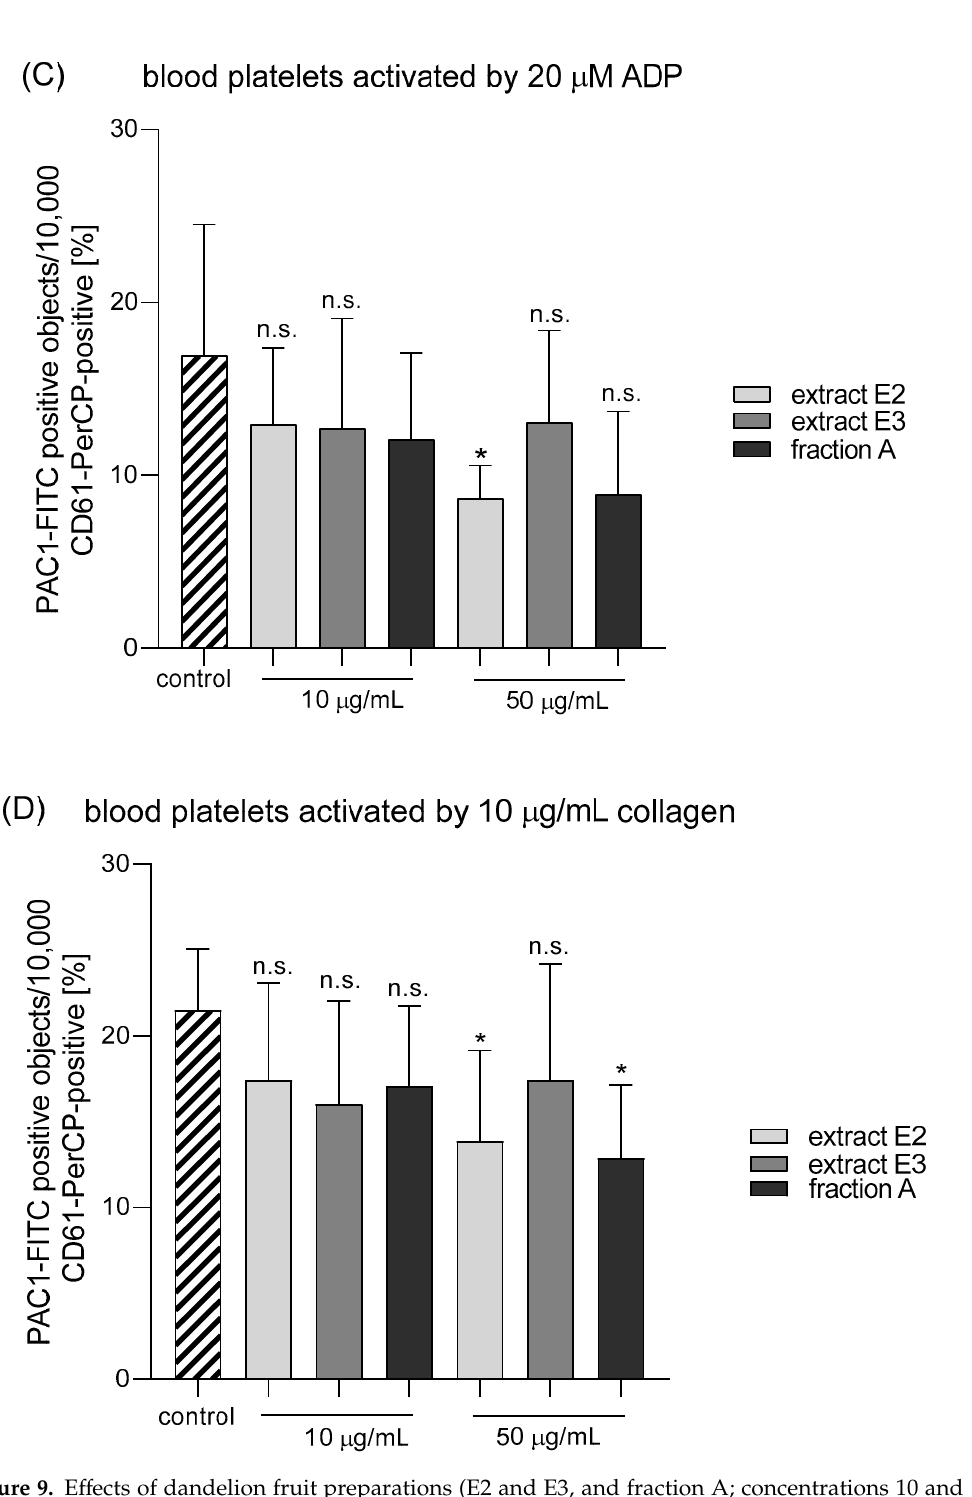
Figure 9. Effects of dandelion fruit preparations (E2 and E3, and fraction A; concentrations 10 and 50 µg/mL) on the expression of the active form of GPIIb/IIIa in resting ( A ) or agonist-stimulated blood platelets: 10 µM ADP ( B ), 20 µM ADP ( C ) and 10 µg/mL collagen ( D ) in whole blood samples. The blood platelets were distinguished based on the expression of CD61. For each sample, 10,000 CD61-positive objects (blood platelets) were acquired. For the assessment of GPIIb/IIIa expression, samples were labeled with fluorescently conjugated monoclonal antibody PAC-1/FITC. Results are expressed as the percentage values of platelets binding PAC-1/FITC. Data represent the means ± SE of six healthy volunteers. n.s. p > 0.05; * p < 0.05 (vs. control platelets).